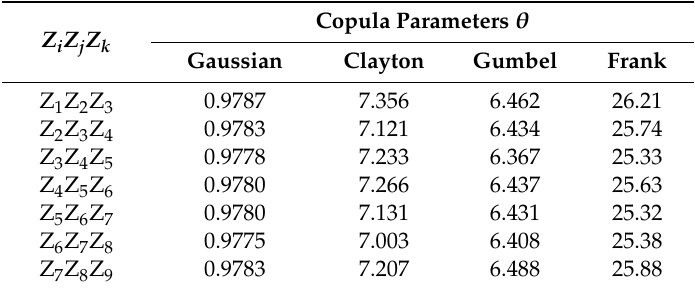
Table 11. The copula parameters for the candidate copulas.